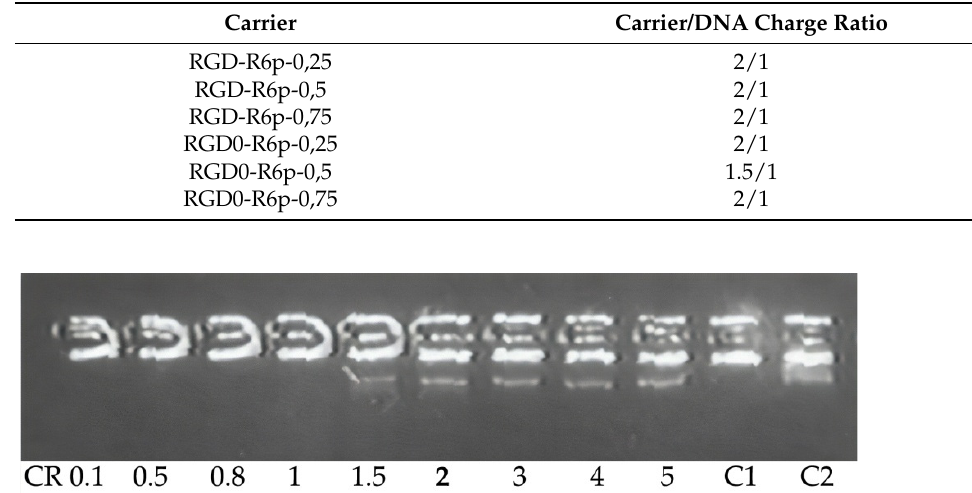
Table 3. DNase I protection ability of peptide/DNA polyplexes.